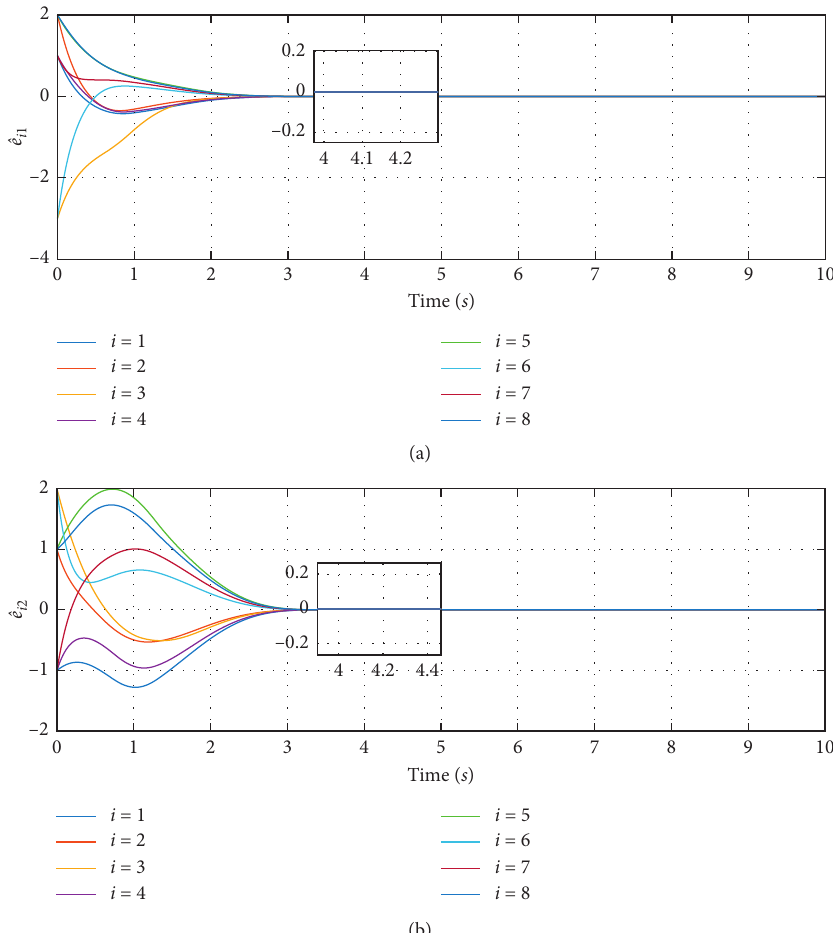
Figure 7: Pictures (a) and (b) reveal the evolution of the errors 􏽢 e